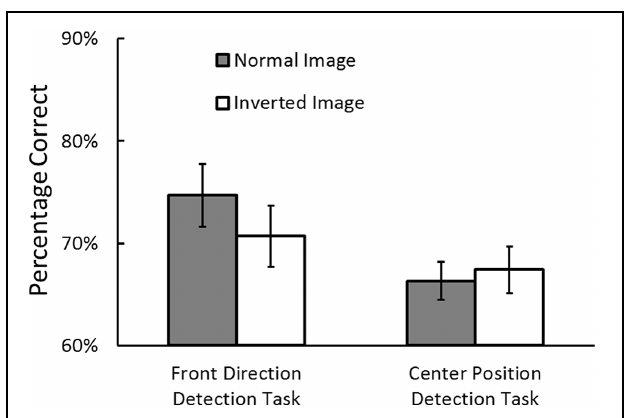
FIGURE 3 | Percentage of correct responses for the front direction detection task (egocentric direction perception) and center position detection task (egocentric position perception) in Experiment 1. Error bars indicate standard errors.